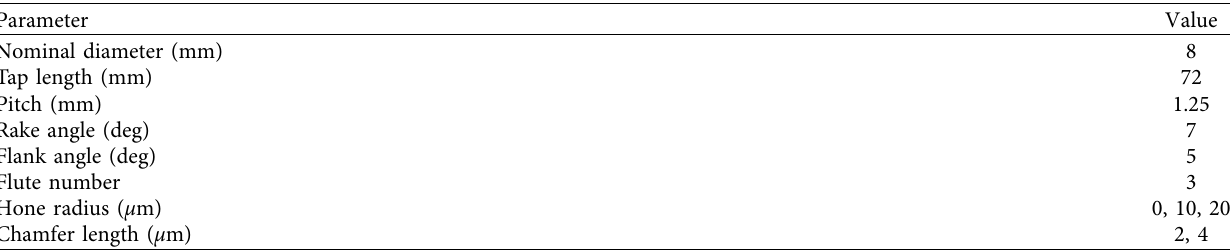
Table 1: Geometric parameters of taps.